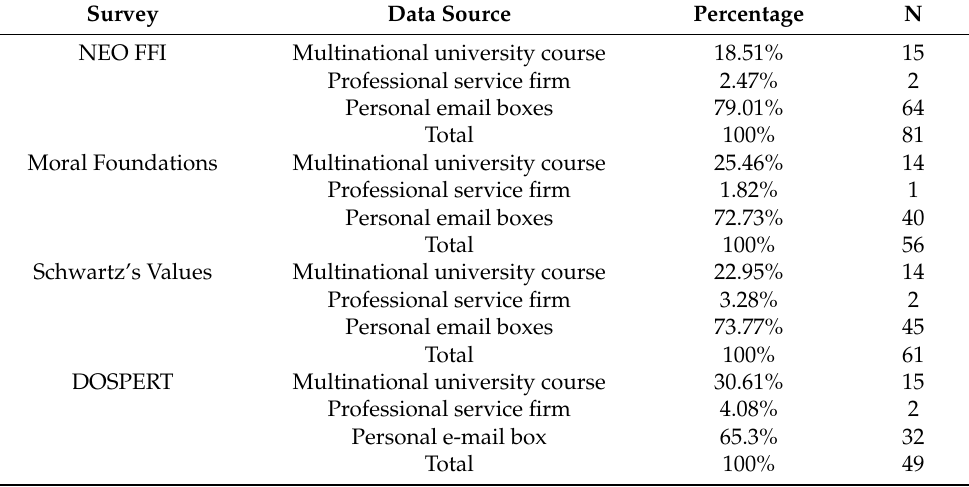
Table 2. Data Source Per Survey.